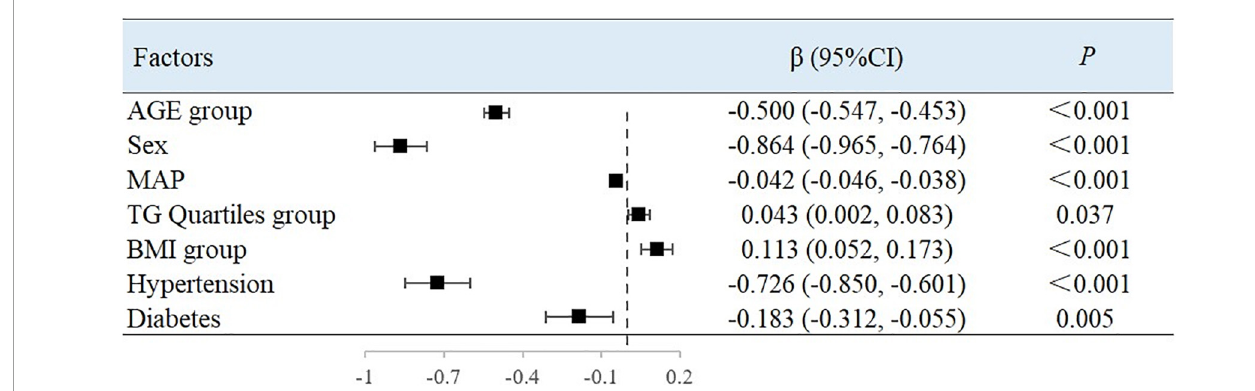
FIGURE1 Factors associated with BAD in multivariate analysis.